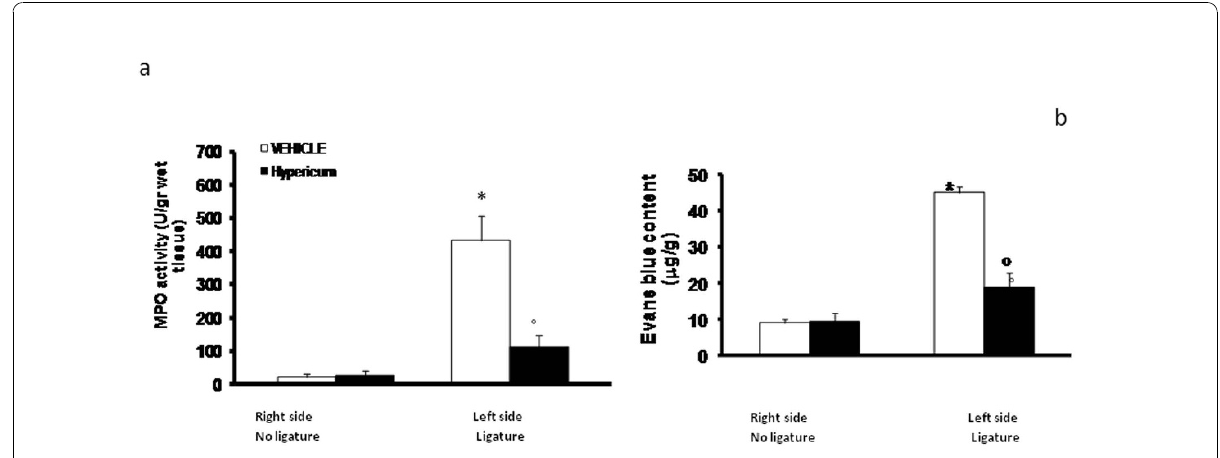
Figure 4 Evans blue content (b) and Myeloperoxidase activity (a) in gingivomucosal tissue was significantly increased by ligature compared to the contralateral side . Hypericum significantly reduced myeloperoxidase activity levels and Evans blue content (a, b respectively). Densitometry data are expressed as % of total tissue area. Data are means of mean ± s.e.m. from N = 10 rats for each group. *P < 0.01 vs. non- ligated. ° < b0.01 vs.